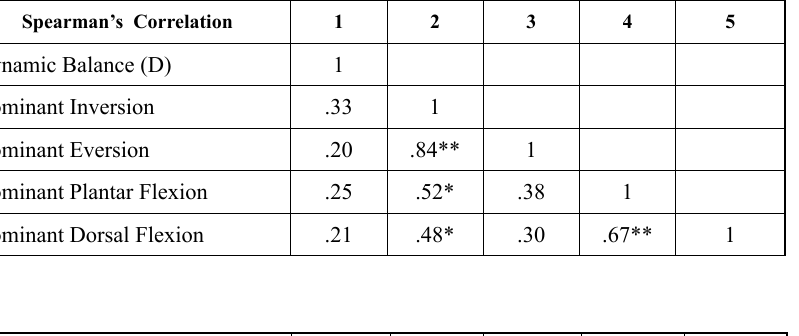
Table 4. Correlation between non- dominant ankle joint muscle strength and dynamic ability average param